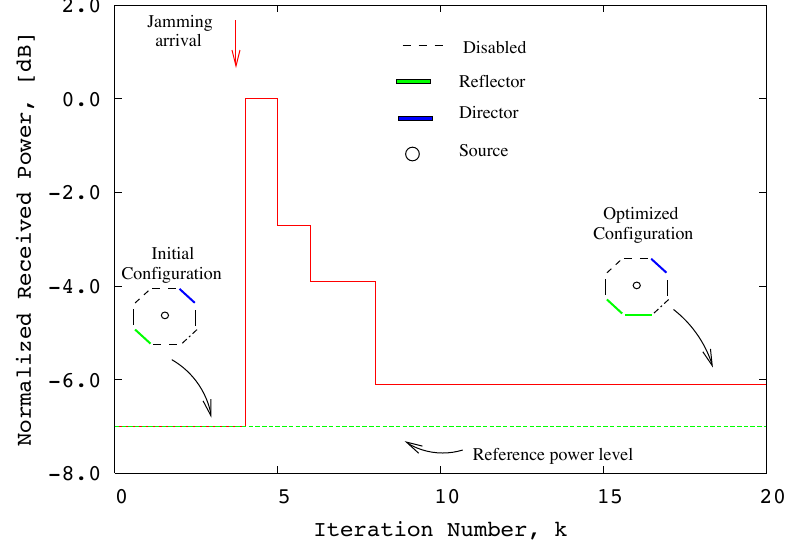
Figure 14. Experimental assessment. Single interfering signal scenario. Behaviour of the normalized receiving power versus iteration